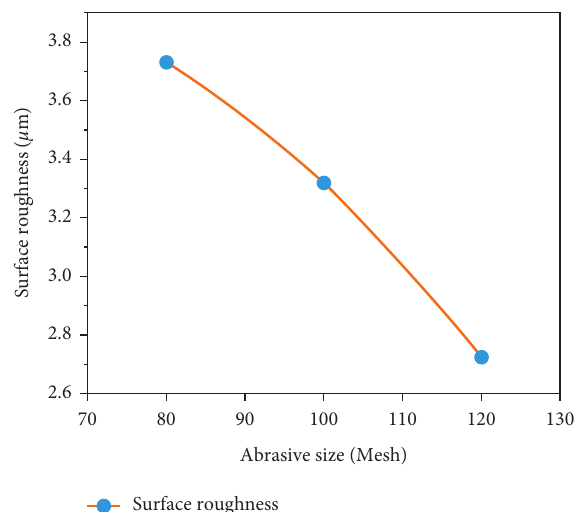
Figure 4: Effect of abrasive size with respect to surface roughness